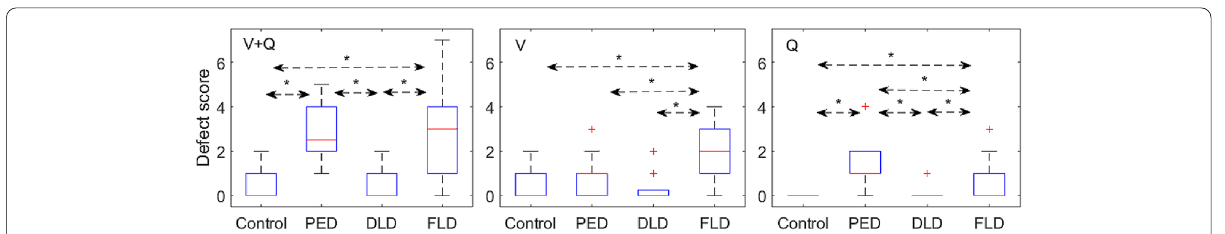
Fig. 2 Comparisons of defect scores for ventilation (middle), perfusion (right) and combined (left) in the four groups. The control group was postoperative ICU patients without acute respiratory failure; PED group: patients with pulmonary embolism-related disease; DLD group: patients with diffuse lung involvement disease; FLD group: patients with focal lung involvement disease. The boxes mark the quartiles with median marked red, while the whiskers extend from the box out to the most extreme data value within 1.5 * the interquartile range of the sample. The red crosses are outliers. * P <